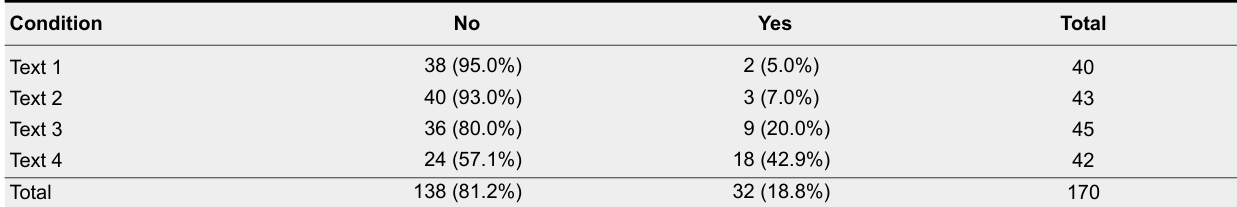
Descriptive Statistics of the Existence (0 = no, 1 = yes) of Agreement With the Text, but not With Its Coarse Rhetoric Style Divided by